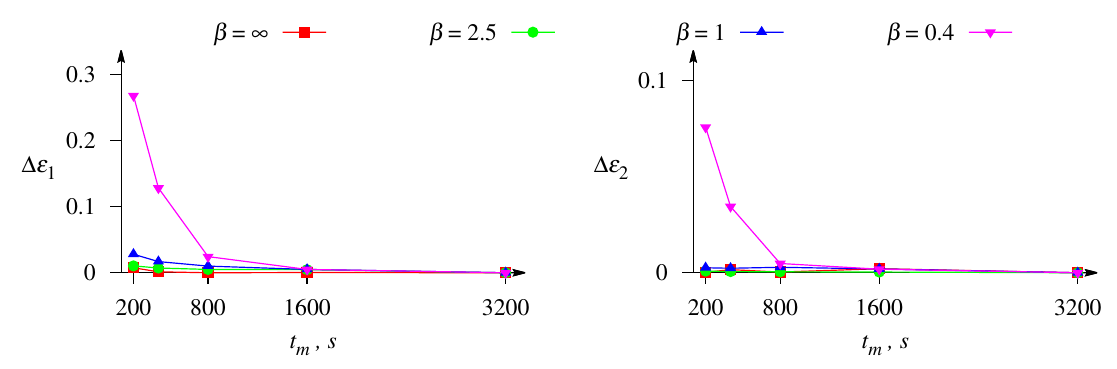
Figure 5. The impairment, ∆ ε , of the relative error, ε , of the evaluation of the i i concentration, c , of the substrate, S , versus the duration, t , of the biosensor operation at i i m four values of the Biot number, β , when the biosensor response is affected by white Gaussian noise with σ = 0 . 05 , i = 1 , 2 . The other parameters are as in Figure